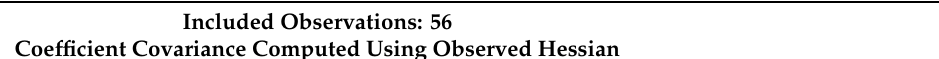
Table 9. Binary logit model results using only statistically significant independent variables for the Business